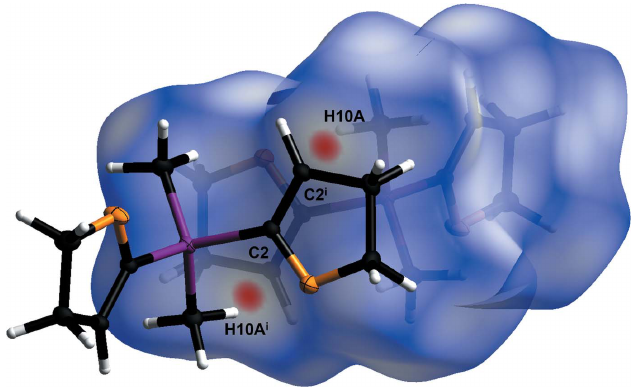
Figure 5 Hirshfeld surface analysis of 1 showing close contacts in the crystal. The van der Waals interaction between carbon atom C2 and the H10 A hydrogen atom is labeled. [Symmetry code: (i) (cid:3) x + 1, (cid:3) y + 2, (cid:3) z ].